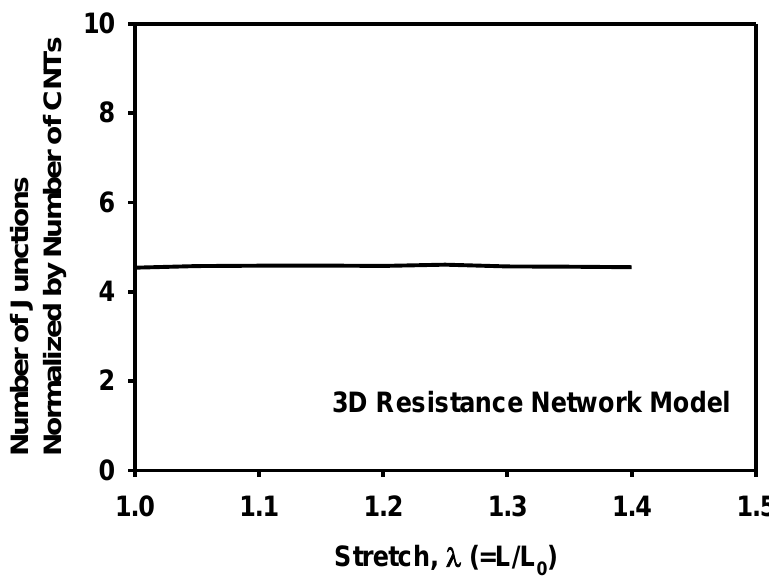
Figure 16. Evolution of normalized number of junctions between CNTs during stretching as calculated by the 3D resistance network model.